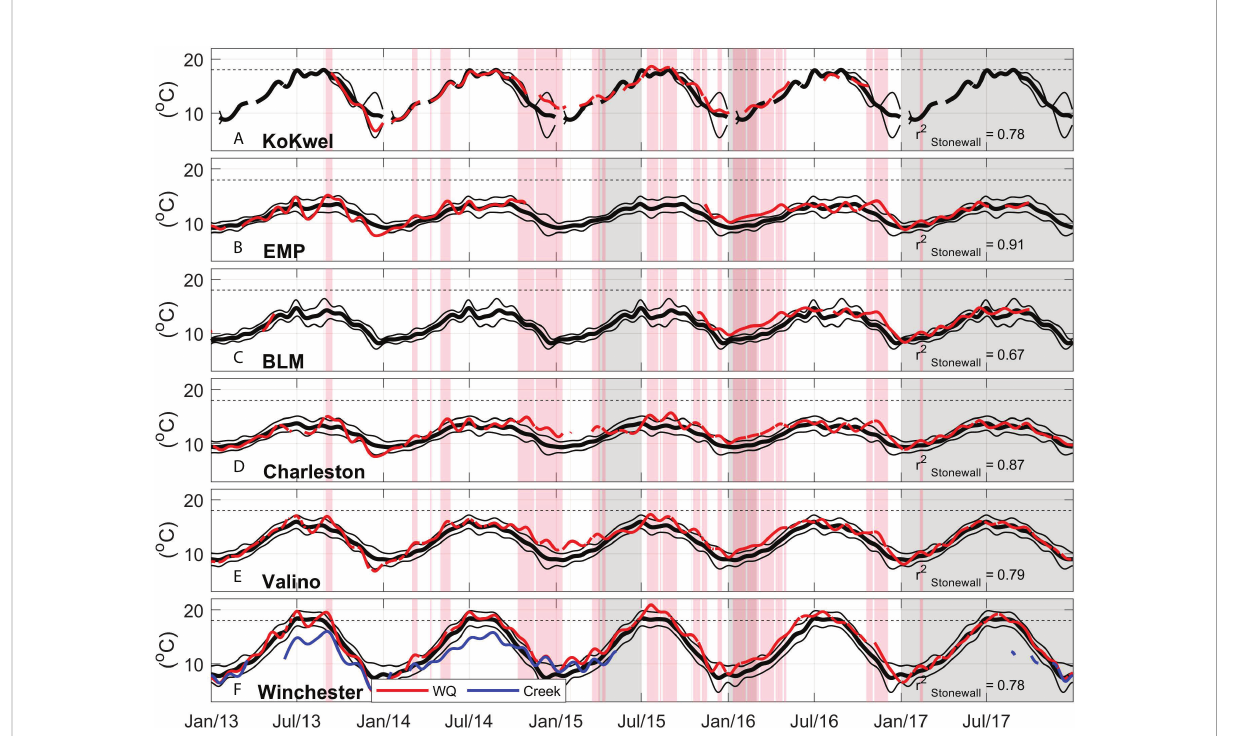
FIGURE 6 Coos Estuary water temperature during 2013-2017, thick black lines show 2004-2014 climatological mean, thin black lines show +/- 1 standard deviation, thin red line shows daily averages with a 30-day low pass fi lter. Red bands show periods in which water temperature at Charleston WQ is 1 standard deviation above the 2004-2014 climatology (black line in Figure 6D). Gray bands show periods in which eelgrass density at Valino is below the 2004-2014 climatology by one standard deviation. Correlation between Charleston WQ and the Stonewall buoy shown in text (signi fi cance level = 0.04). (A) KoKwel Wharf, (B) EMP, (C) BLM, (D) Charleston, (E) Valino and (F) Winchester WQ and Winchester Creek (blue). 18 °C eelgrass temperature threshold in broken black line for